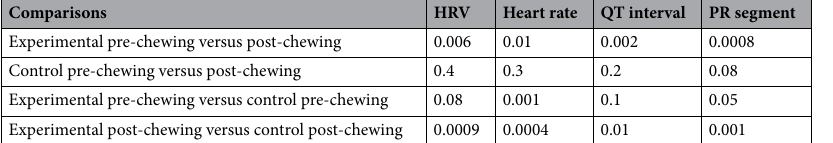
Table 3. Statistical analysis ( p values) for experimental and control groups (pre-and post-chewing) for sample measurements.